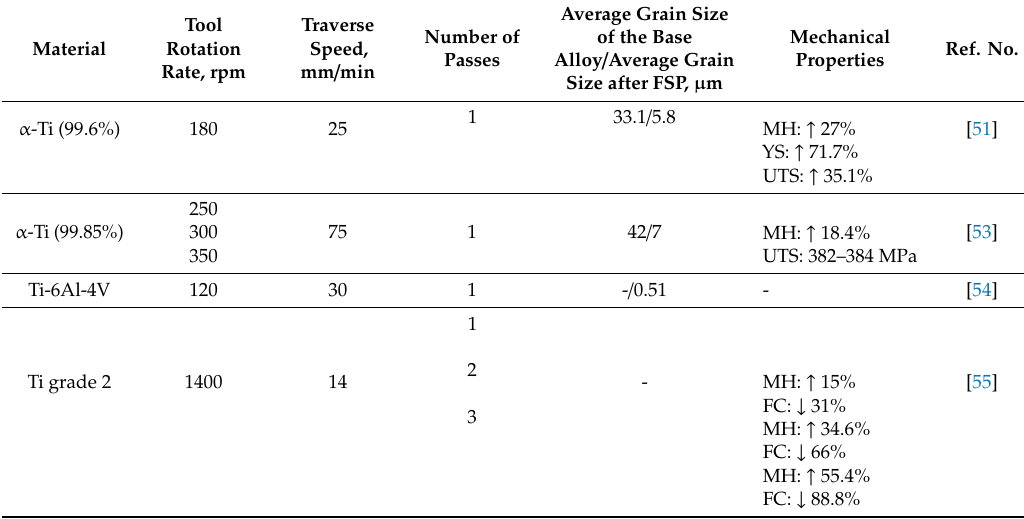
Figure 5. Macrostructure of single-pass FSPed titanium (reproduced from [51], with permission from Elsevier, 2019): ( a ) region processed at 180 rpm; ( b ) EBSD map of pure titanium sheet; EBSD maps of the specimen cross sections processed at 180 rpm ( c ) and 270 rpm ( d ). Table 3. Experimental data on FSP of titanium alloys.